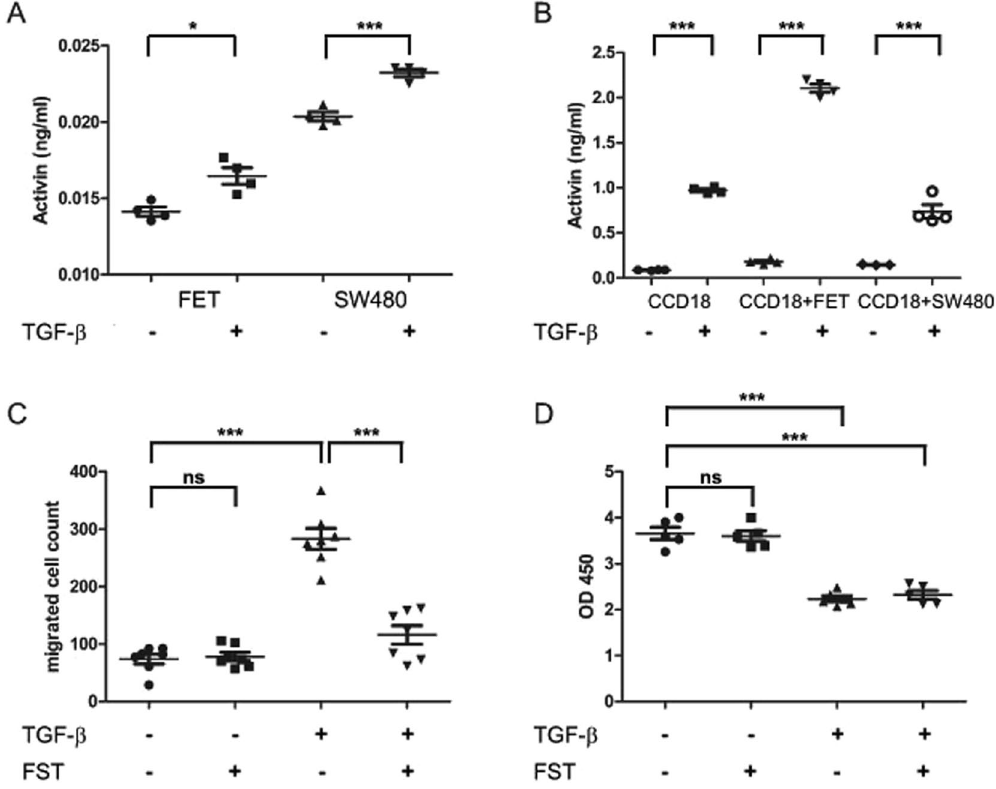
Figure 2. TGF- β ’s pro-metastatic function is activin dependent while its anti-proliferative function is independent of activin. TGF- β increases activin secretion in both epithelial ( A ) and stromal ( B ) cells. ( A ) Activin ligand from respective CRC cell culture supernatants as measured by ELISA with and without treatment with 10 ng/ml of TGF- β . ( B ) Activin ligand from CRC cells with or without co-culture with CCD18 stromal cells. Cells were treated with either vehicle control (PBS) or 10 ng/ml TGF- β . ( C ) TGF- β pro-migratory effects are activin dependent. Transwell migration assay of FET colon cancer cells treated with either the activin inhibitor follistatin (FST, 100 ng/ml) or TGF- β (10 ng/ml) or both as indicated. Cells were imaged and counted as described in Materials and Methods. D) TGF- β induced anti-proliferative effects are activin independent. Metabolic activity as an approximation of cell proliferation of FET CRC cells treated with either follistatin (FST, 100 ng/ml) or TGF- β (10 ng/ml) or both as indicated was measured by wst-8-based cell counting assay and reported as OD450. All experiments shown were reproduced at least twice with at least a total n = 5.